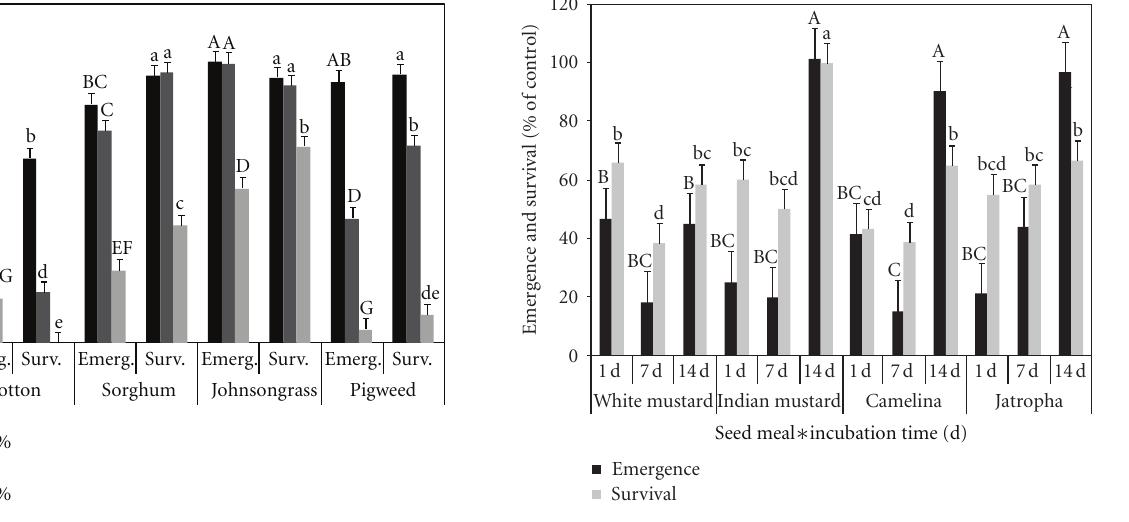
Figure 3: Seed meal rate e ff ect on cotton, sorghum, Johnsongrass, and pigweed emergence and survival. Means followed by the same letter are not di ff erent at P < 0 . 05 by Fisher’s protected LSD. Uppercase letters separate emergence means and lowercase letters separate survival means. Data are means (four replications) ± SE.